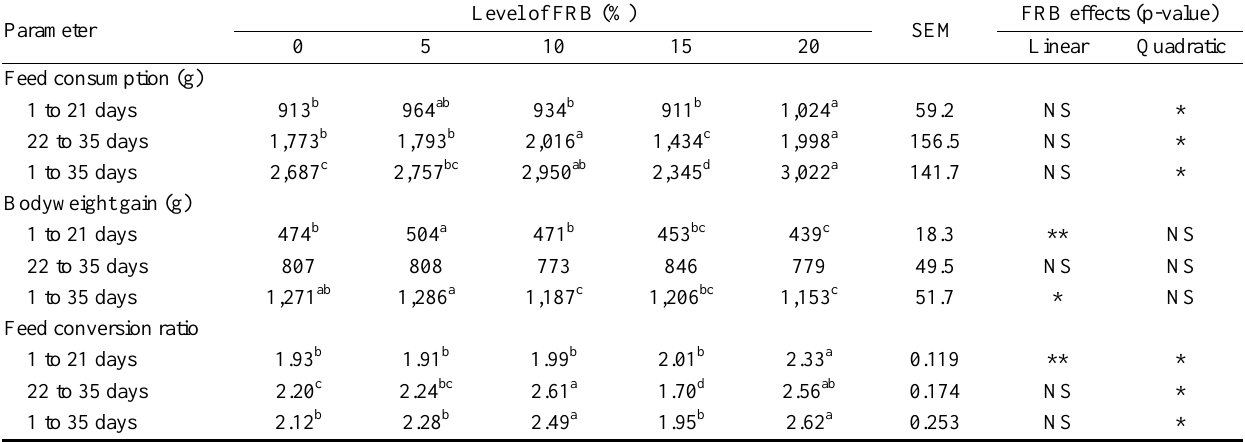
Table 4. Growth performances of broiler chicks fed different levels of fermented rice bran (FRB)